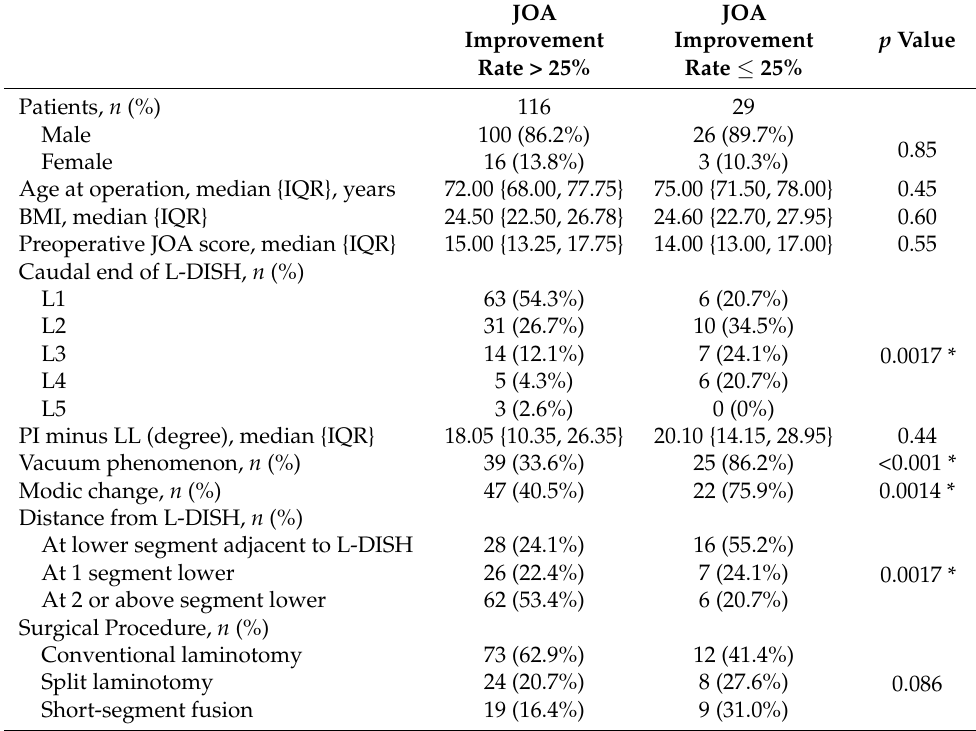
Table 3. Comparison of L-DISH patients with and without JOA improvement rate >